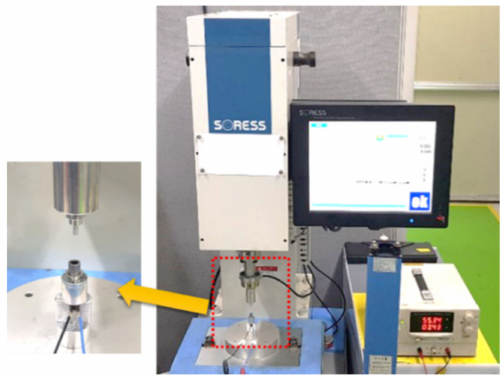
Figure 18. Magnet force tester of TCV.